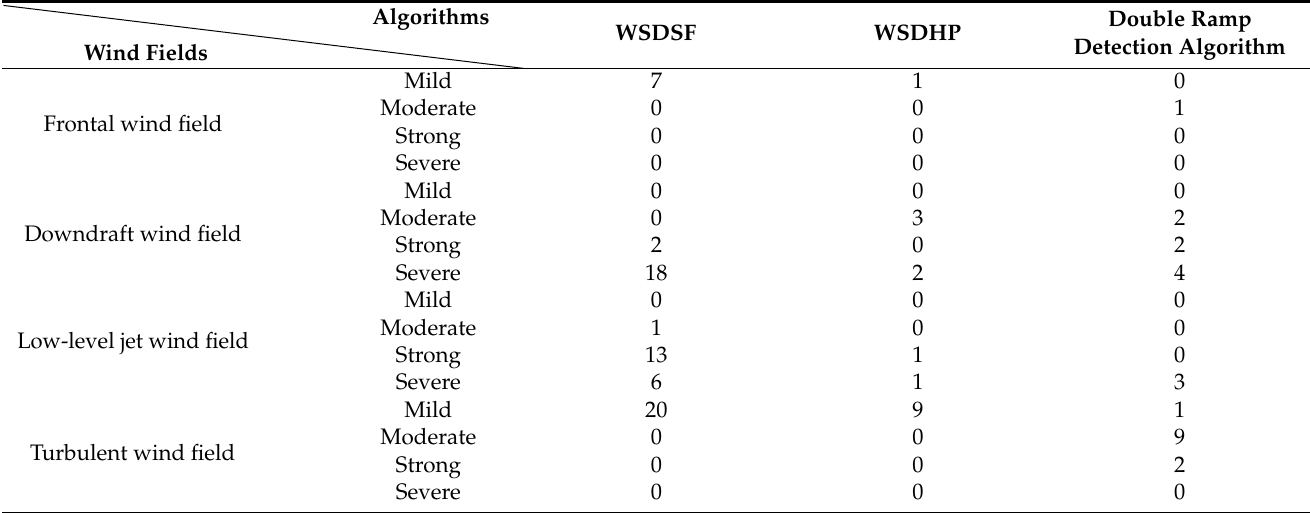
Table 2. The number of wind shear alerts of different levels under different wind